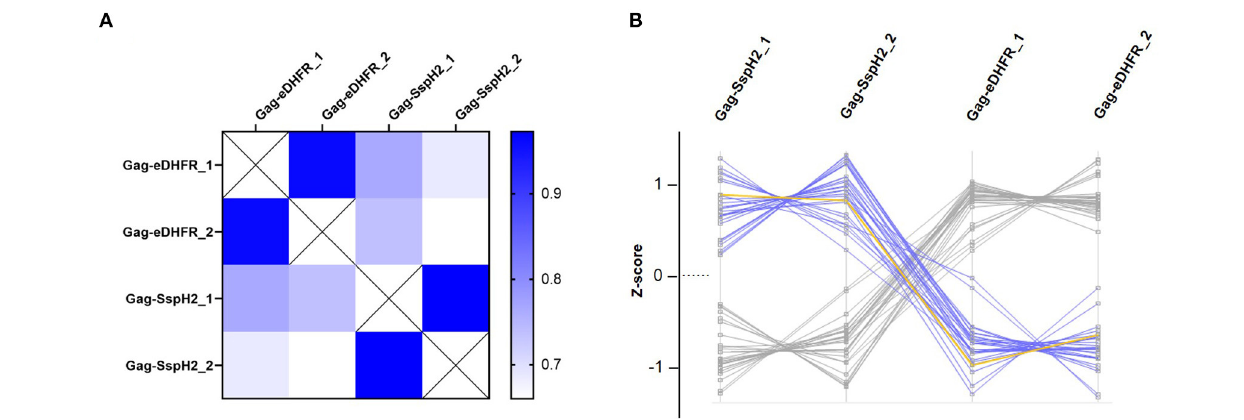
FIGURE 4 | Quality control and data exploration of Virotrap samples. (A) Heat map visualization of pairwise LFQ Pearson correlations were calculated for duplicate (annotated “_1” and “_2”) Virotrap control (Gag-eDHFR) and effector (Gag-SspH2) samples. (B) Profile plots of significantly enriched protein identifications are shown after z-scoring of corresponding (imputed) LFQ intensities in the Virotrap samples. Proteins uniquely identified in the Virotrap control samples were excluded from the statistical analysis and are not shown in the profile plot. Blue highlighted lines represent significant hits co-enriched with Gag-SspH2 (yellow line) vs. the Virotrap Gag-eDHFR control setup (Limma, p -value <